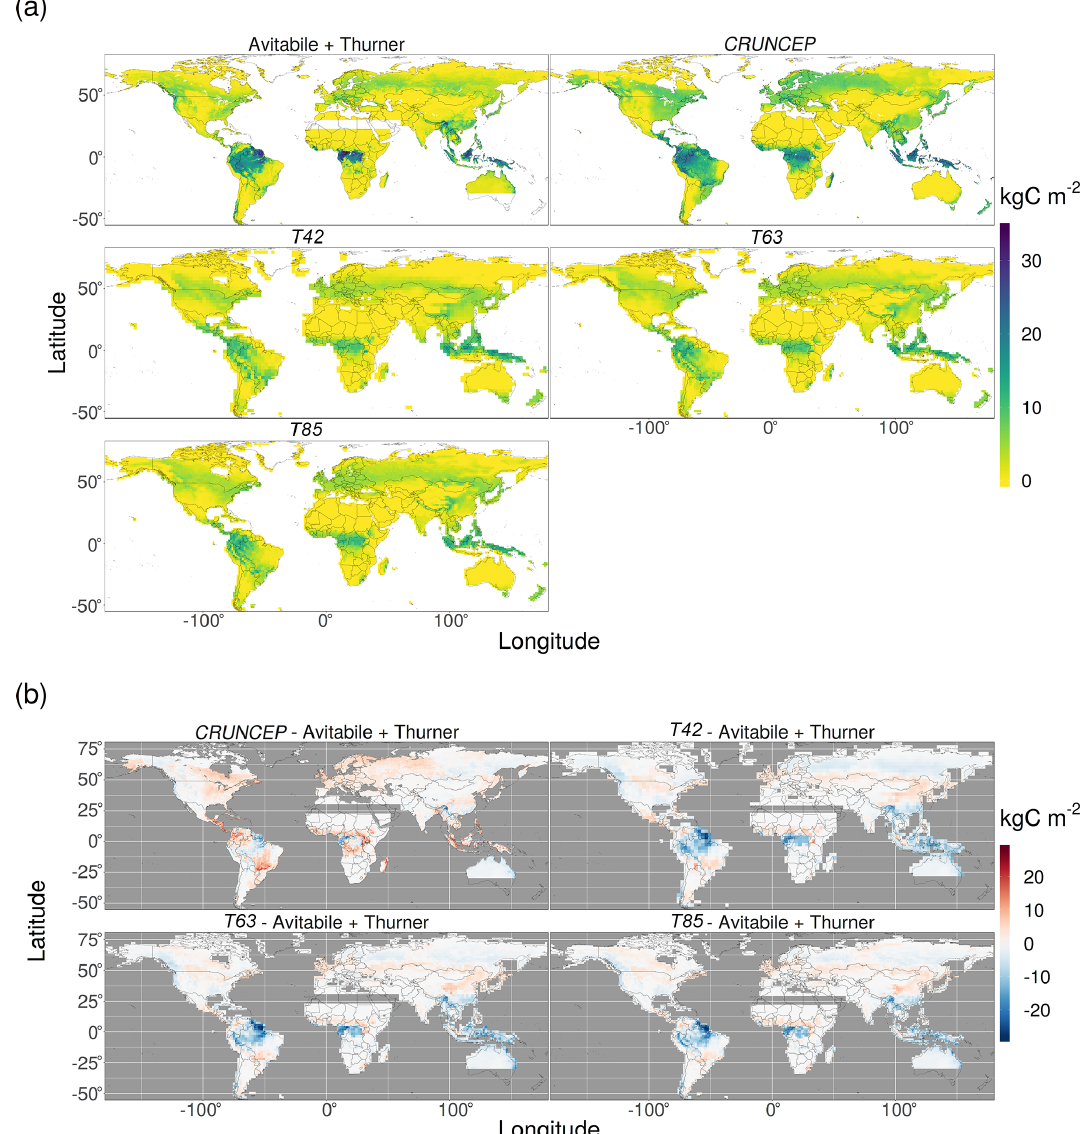
Figure 5. Comparison of biomass from the T42 , T63 , and T85 (EMAC climate) and CRUNCEP (observed climate) simulations with ob- served biomass from Avitabile et al. (2016) and Thurner et al. (2014); (a) absolute values and (b) the difference between simulations minus observation. Note that neither the Avitabile et al. (2016) nor the Thurner et al. (2014) biomass dataset provides biomass for a band across the Sahara, Arabian Peninsula, and in southern Australia, so no data are plotted